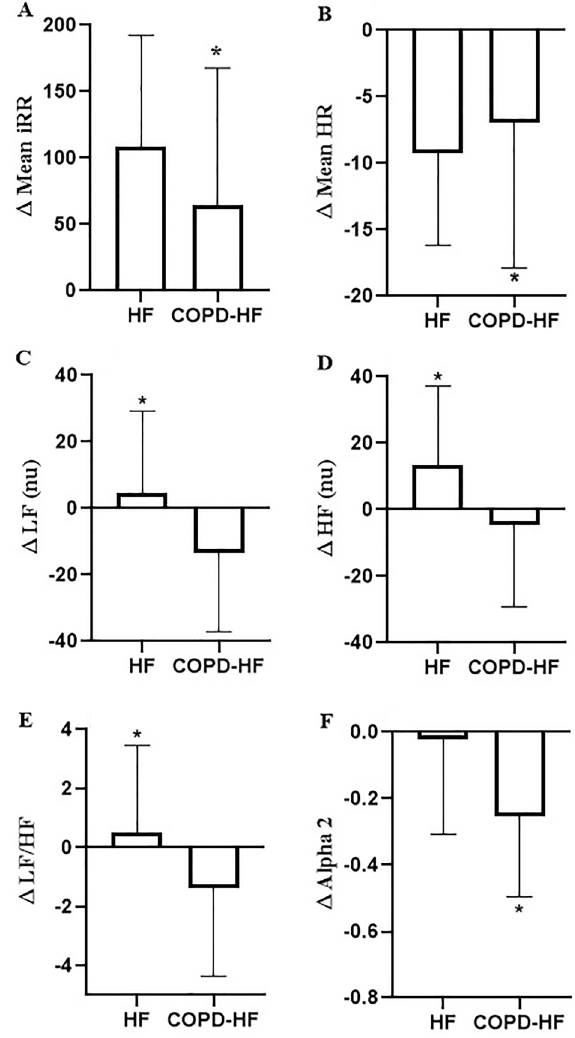
Figure 3. Comparison of heart rate variability indices in D active postural maneuver of heart failure (HF) patients and chronic obstructive pulmonary disease-heart failure (COPD-HF) patients. Data are reported as means ± SD. *P=0.05 (Student ’ s t -test). iRR: R-R intervals; HR: heart rate; LF: low frequency in normal- ized units; HF nu: high frequency in normalized units; Alpha 2: long-term fl uctuations of detrended fl uctuation